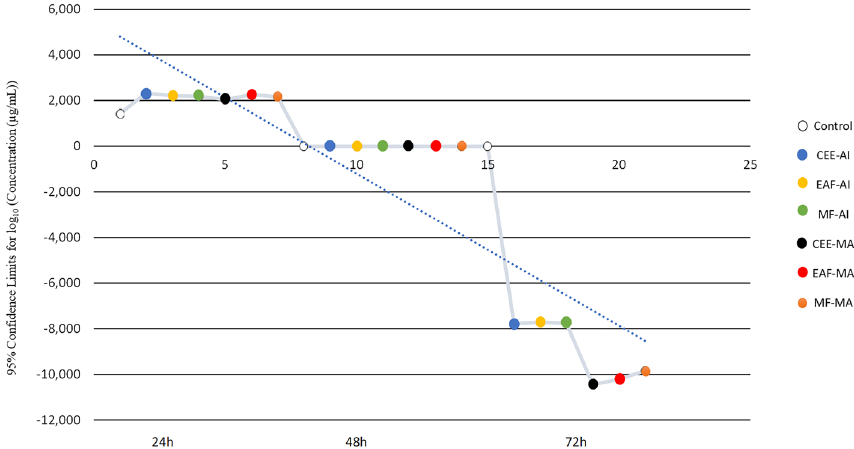
Figure 1. Estimate visualized in log10 with a reliability limit of 95% (Concentration (µg/mL)) in which can be observed the dependent variable “y” (concentration) as a function of “x” (time). The longer the concentrations of extracts of Azadirachta indica. and Melia azedarach and are in contact with Artemia Salina , the greater the toxicity level, thus reducing the number of living crustaceans in the study. CEE-AI: crude ethanolic extract— Azadirachta indica ; EAF-AI: ethyl acetate fraction— Azadirachta indica ; MF-AI: fraction methanol— Azadirachta indica ; CEE-MA: crude ethanolic extract— Melia azedarach ; EAF-MA: ethyl acetate fraction— Melia azedarach ; MF-MA: fraction methanol— Melia